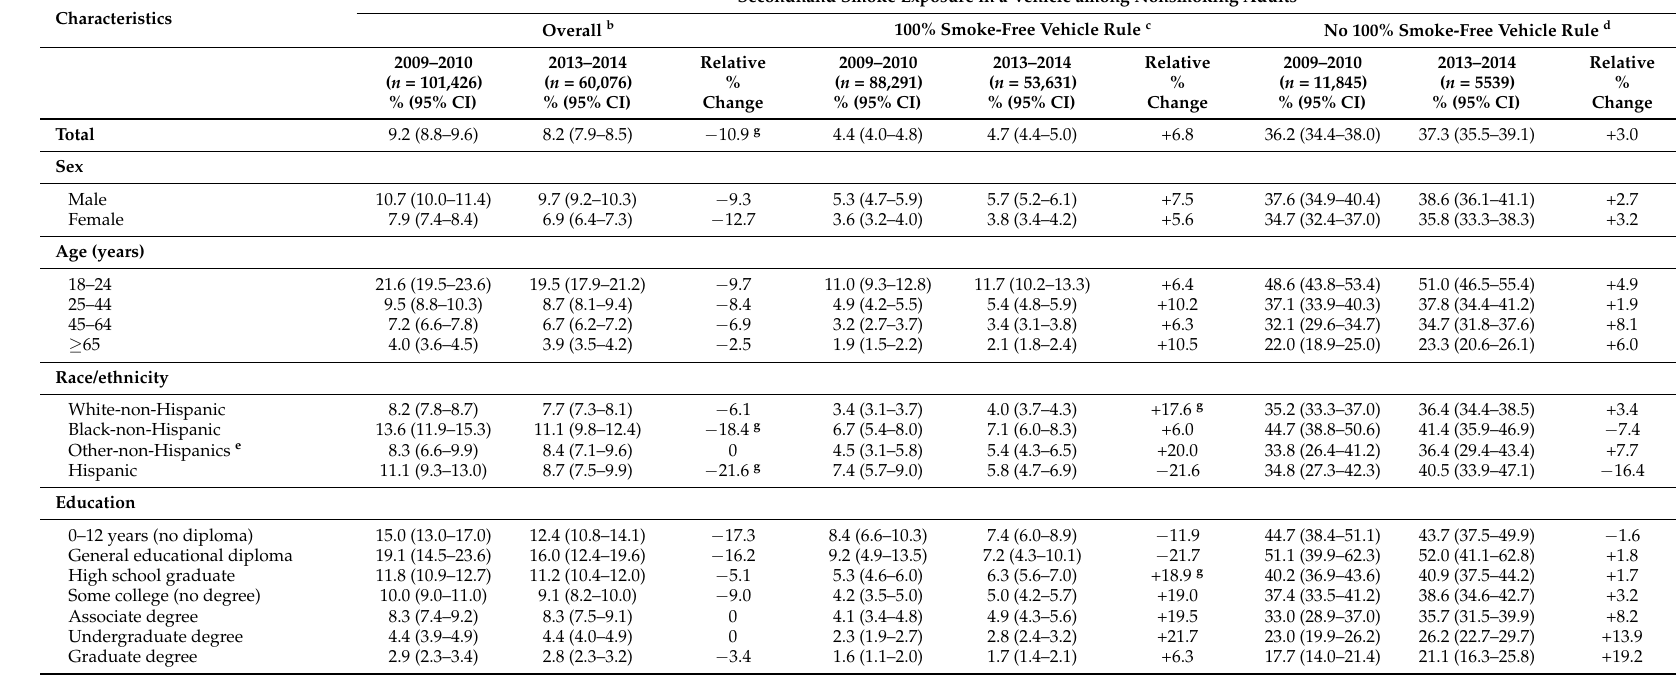
Table 2. Percentage of nonsmoking U.S. adults who reported exposure to secondhand smoke in a vehicle in which they rode during the previous 7 days, overall